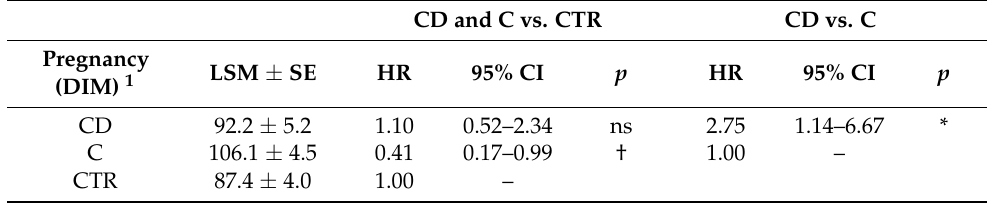
Table 2. Least square means (LSM) and standard errors (SE) of days in milk (DIM) at pregnancy in the three treatment groups, CD (ceftiofur + ketoprofen), C (ceftiofur), and CTR (control), of 20 cows each, as resulted from the survival analysis. Hazard ratio (HR) and 95% CI of becoming pregnant within 120 DIM, as resulted from the Cox proportional hazard model for both the comparisons (CD and C vs. CTR, and CD vs. C), are reported too.